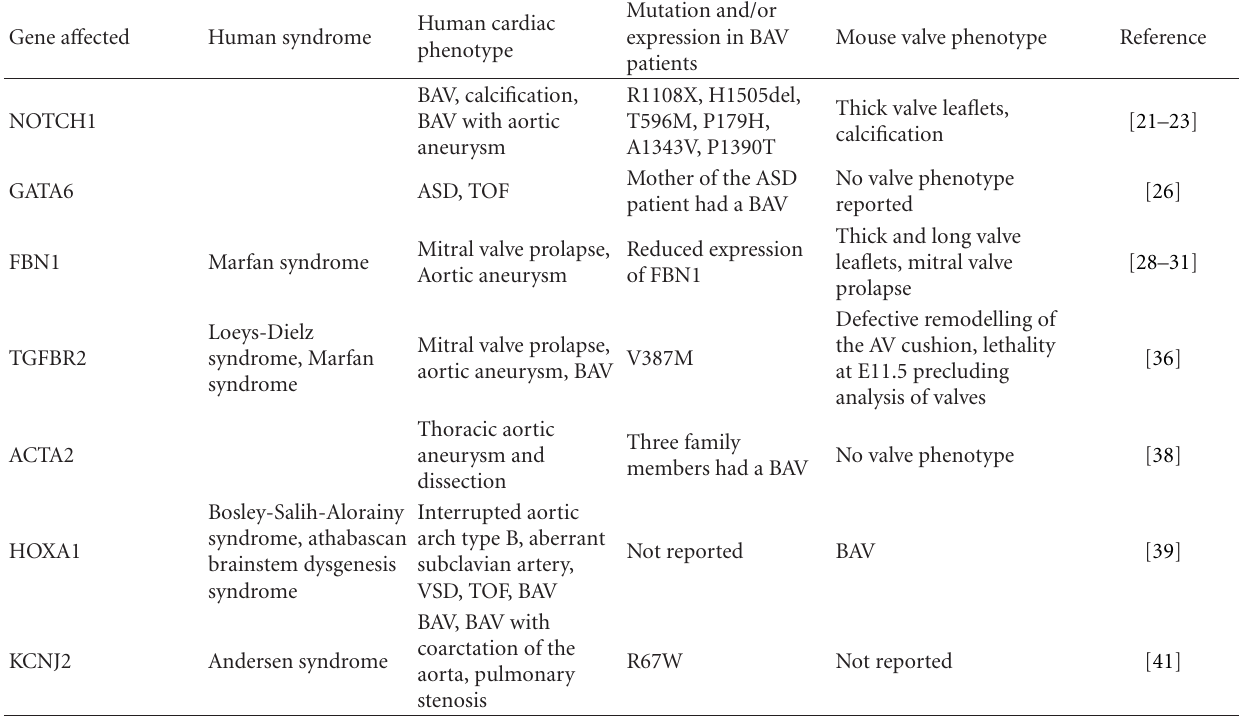
Table 1: Human gene mutation and phenotype associated with bicuspid aortic valve